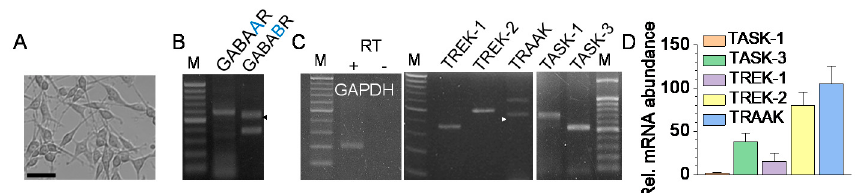
Figure 1. Expression of the K 2P channels in B35 cells. ( A ) A photomicrograph of B35 cells cultured in a 24-well culture dish. Scale bar, 50 μ m. ( B ) Expression of GABA A and GABA B receptors. ( C ) Expression of TREK-1, TREK-2, TRAAK, TASK-1, and TASK-3 corresponding to the expected sizes of 361 bp, 493 bp, 445 bp, 702 bp, and 517-bp, respectively. The first, fourth, and tenth lanes presented 100 bp DNA ladders. RT + and RT – indicated, respectively, reactions with and without reverse transcriptase. The arrowheads indicate the GABA B receptor and TRAAK bands. ( D ) Relative mRNA abundance of the K 2P channels. The mRNA expression levels of TASK-1, TASK-3, TREK-1, TREK-2, and TRAAK were quantified by real-time PCR. The mRNA expression level was normalized to GAPDH. Each bar represents the mean ± SD of four independent experiments.